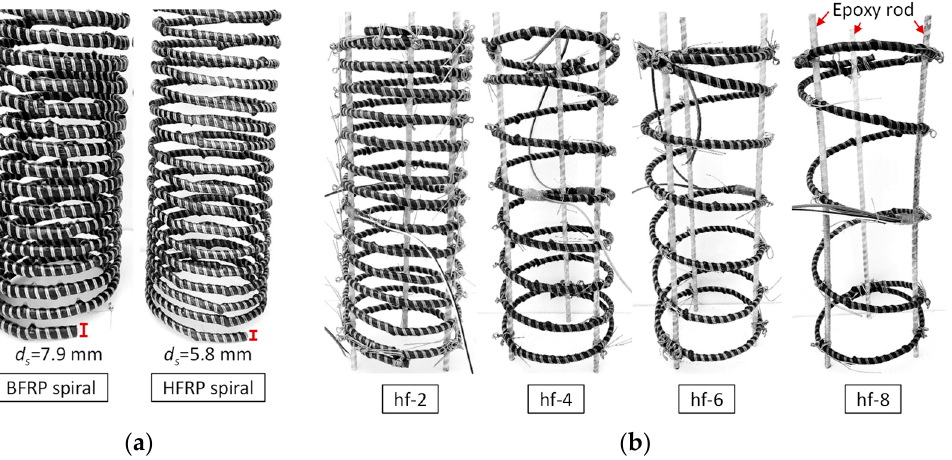
Figure 1. Different spirals and reinforcement cages in test cylinders: ( a ) different spirals; ( b ) reinforcement cages with different spacings.